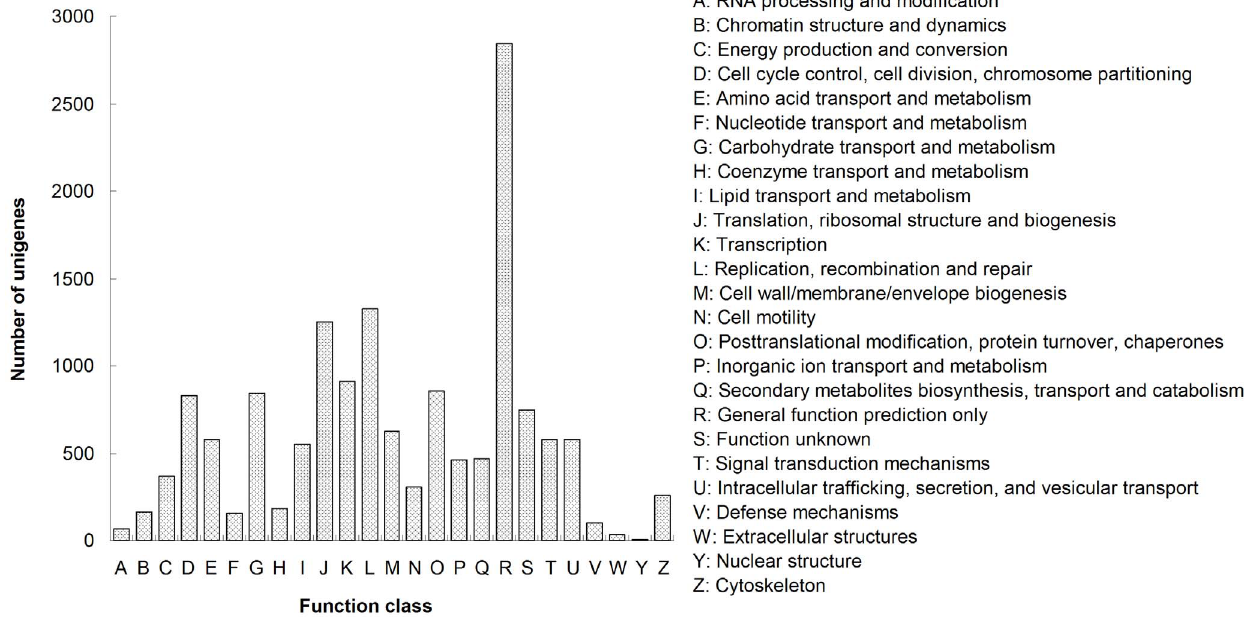
Figure 2. Histogram presentation of COG classification. In total, 15,082 unigenes were grouped into 24 COG classifications. doi:10.1371/journal.pone.0081096.g002 PLOS ONE |